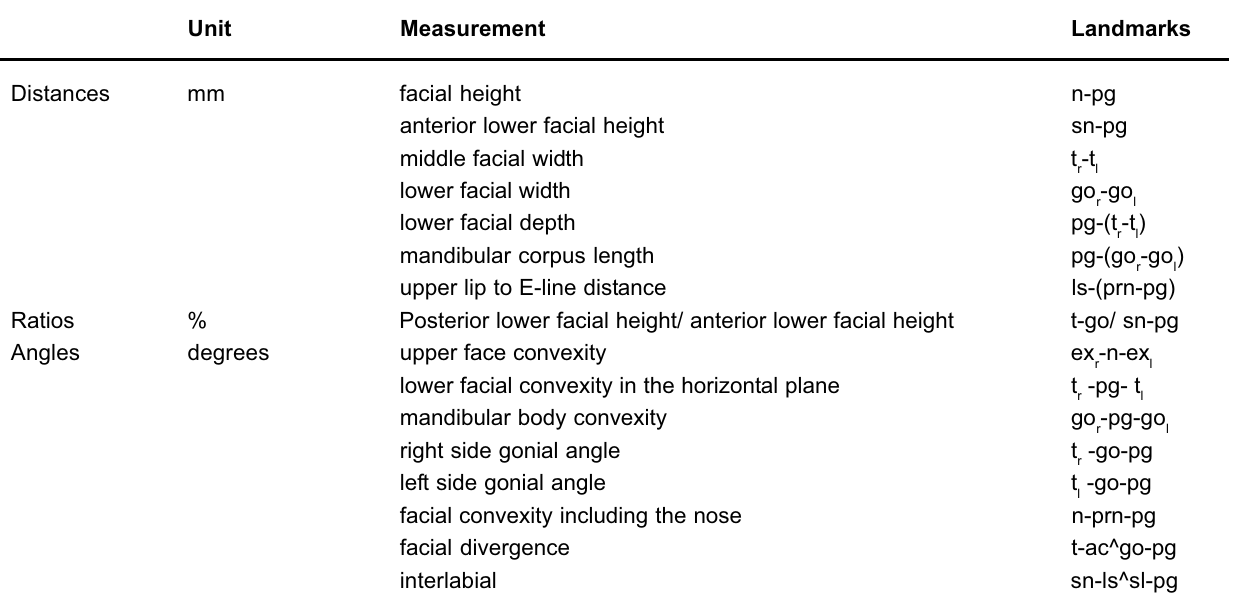
TABLE 2- Measurements calculated from the digitized